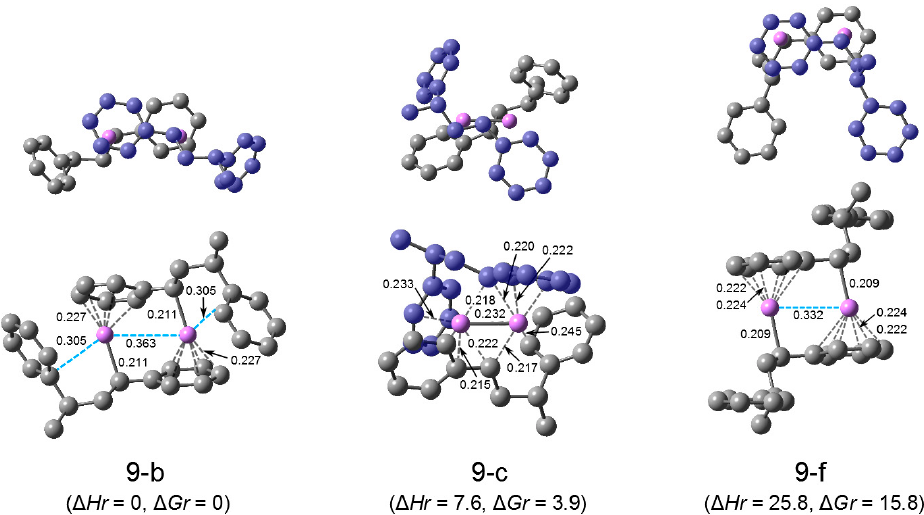
Figure 9. Optimized geometries and relative energies of representative (HSt 2 Li) 2 structures with and without the penultimate unit coordination in the gas phase. The small drawing on the upper part of each structure is the overhead view of the lower drawing; the carbon atoms of one HSt 2 Li (the upper HSt 2 Li in the lower drawing) are colored in blue. For the lower drawings of (9-c), the carbon atoms of the upper HSt 2 Li are also colored in blue for clarification. Hydrogen atoms are not shown. C–Li distances less than 0.225 nm and the distances between Li and the nearest penultimate-unit carbon are shown in the lower drawings. ∆ Hr and ∆ Gr , the relative enthalpy and relative free energy, are expressed in kJ·mol –1 .